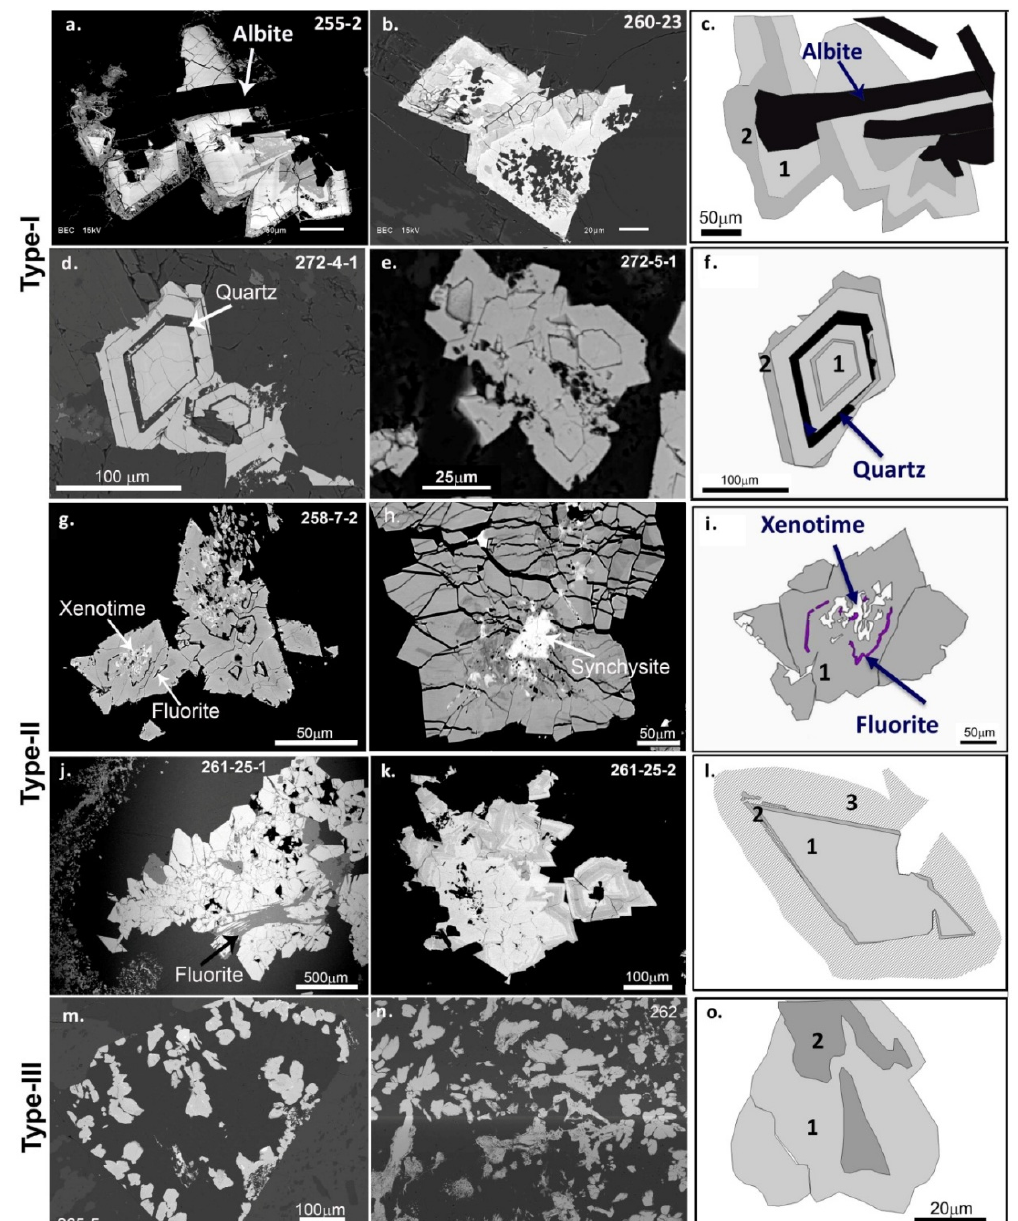
Figure 5. Zircon type and schematic drawings for cathodoluminescence images. ( a , b ) Type-Ia zircon from quartz syenite, zircon is show subhedral to euhedral shape, metamict zoning, and porous core. ( c ) Schematic drawing of Type-Ia zircons that consist of two domains, a bright CL domain 1, and grey CL domain 2. ( d , e ) Type-Ic zircon from granite. Zircon shows subhedral to euhedral shape and includes a thin quartz band. ( f ) Schematic drawing of Type-Ic zircons that consist of two domains, a grey CL domain 1, and bright CL domain 2. Two domains show zoning and contain dark quartz bands. ( g , h ), and ( j , k ) Type-II zircons from hydrothermal altered quartz syenite. These zircons show bright and dark color layered chemical zoning with porous cores. Xenotime and synchysite exist as inclusions in the zircon, ( i ) Schematic drawing of Type-II zircon. CL image shows dark grey solid domain 1, with white bright CL fluorite band (purple) and bright xenotime in the core, ( l ) Schematic drawing of Type-II zircon, with a grey CL euhedral core (domain 1), dark grey CL rim (domain 2) and whitish grey CL radiation halo in quartz (domain 3). Dark grey rim parts contain high Th concentration that attributed radiation halo. ( m , n ) Type-III zircons in the quartz syenite. Zircons are anhedral, fine-grained, and occur in an amphibole pseudomorph with quartz and fluorite. ( o ) Schematic drawing of Type-III zircons with anhedral grey and dark CL domains.